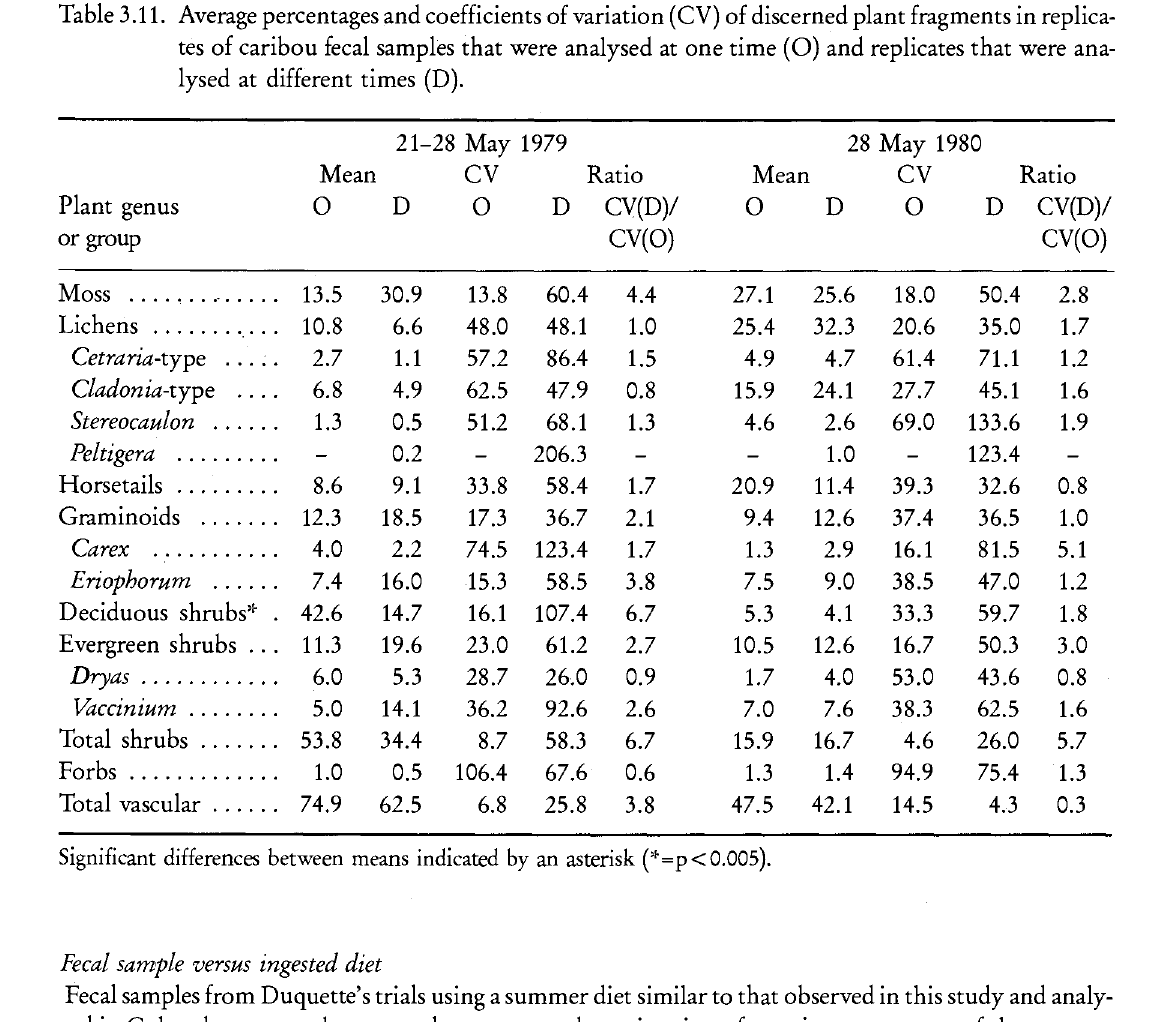
Table 3.11. Average percentages and coefficients of variation (CV) of discerned plant fragments in replica tes of caribou fecal samples that were analysed at one time (O) and replicates that were ana lysed at different times